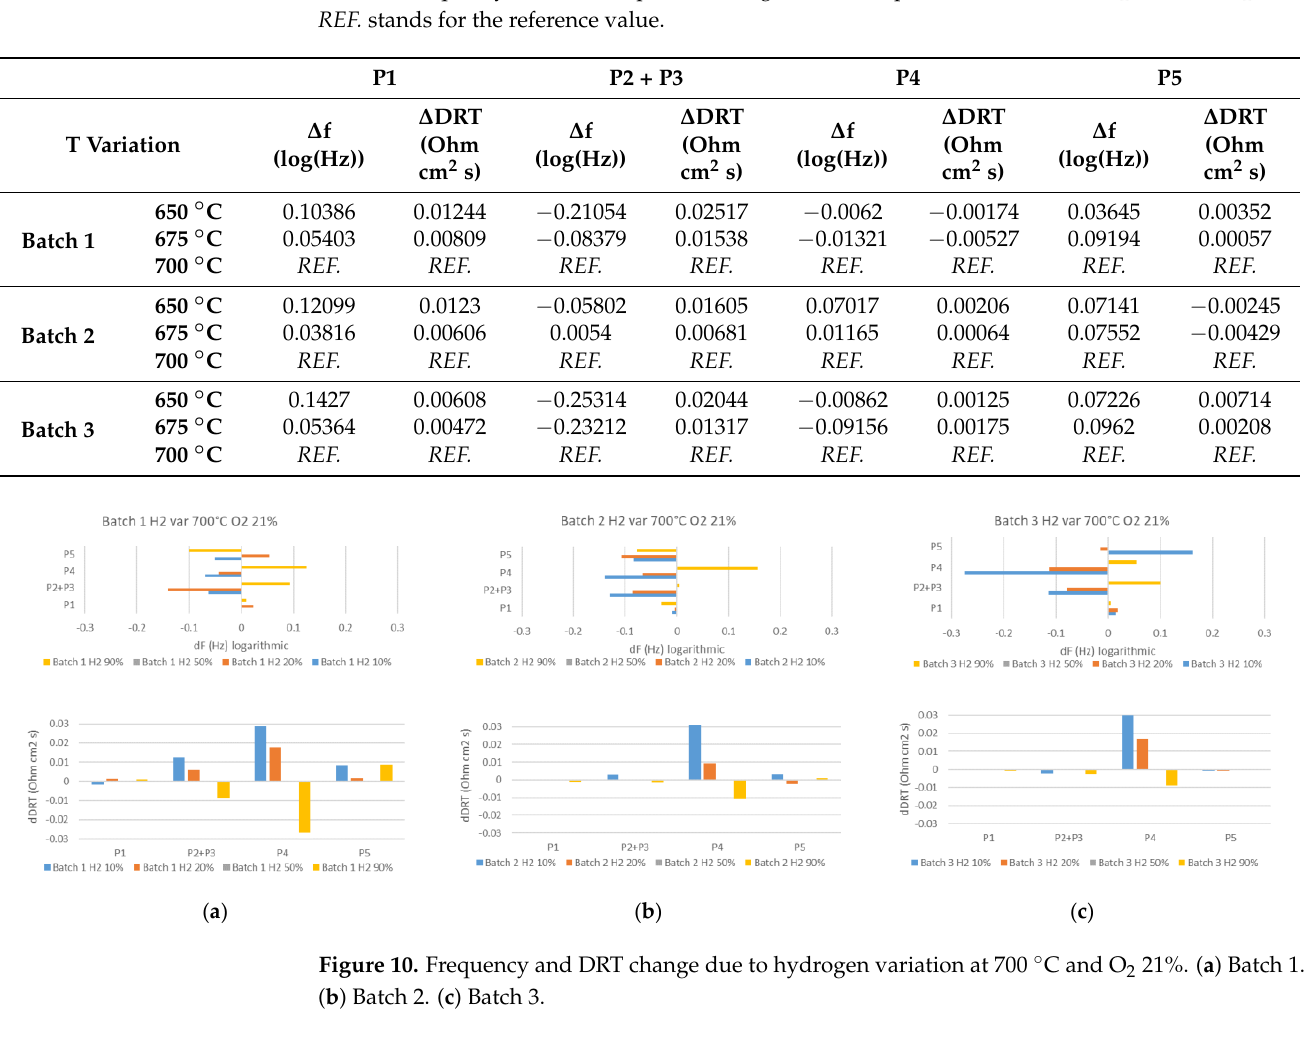
Table 6. Frequency and DRT amplitude change due to temperature variation at H 2 50% and O 2 21%. REF. stands for the reference value.